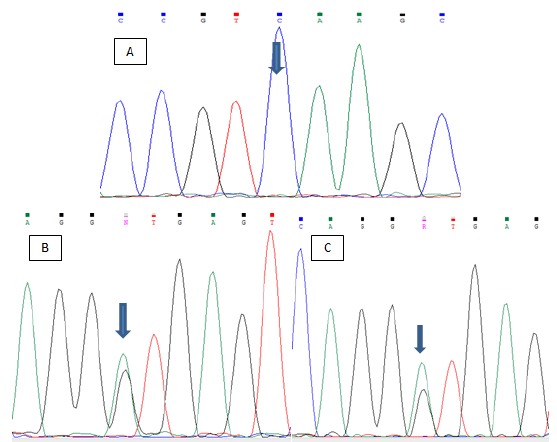
Figure 1. The PCR sequencing analysis of the cases: ( A ) The Hb Constant Spring mutation on α -globin gene of female case. ( B ) The position of c.315 + 1 G > A mutation on male case ( C ) The position of c.315 + 1 G > A mutation on female subject.